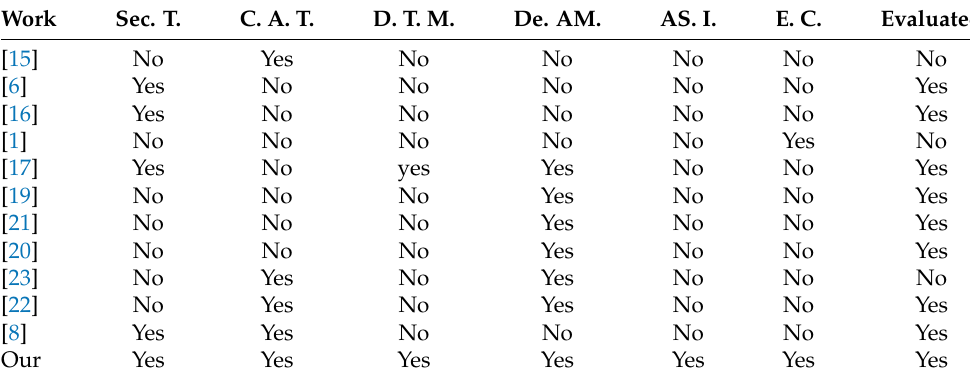
Table 1. Comparison of the authorization management systems